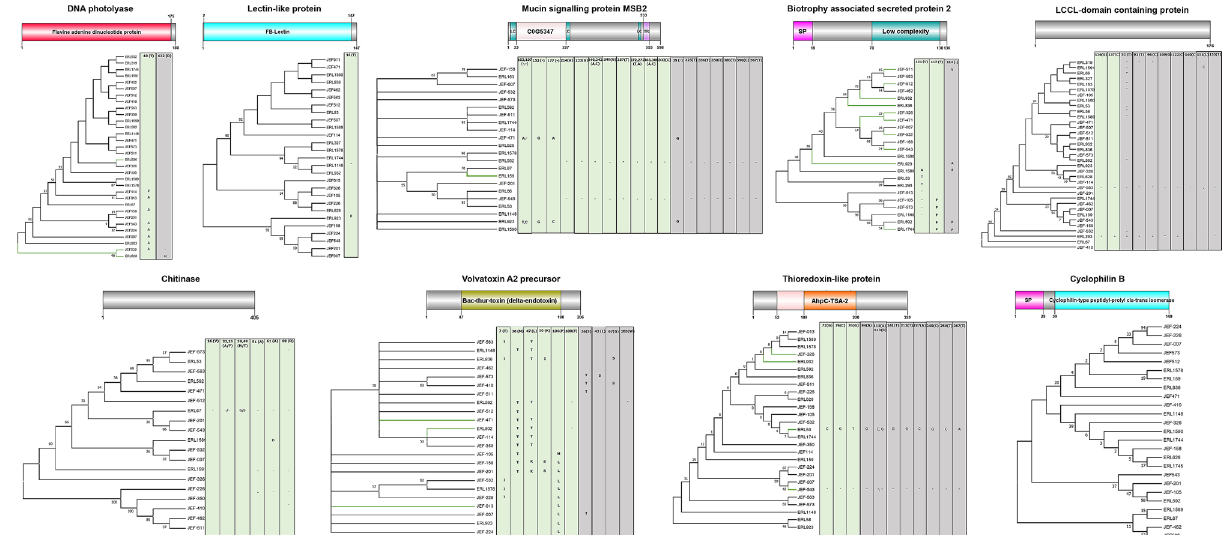
Figure 2. Positive selection pressures in nine genes of B. bassiana isolates. In each gene, domain architecture, phylogenetic relationship, and changes of amino acids were analysed. In the phylogenetic trees, the isolates with green branches are under positive diversifying